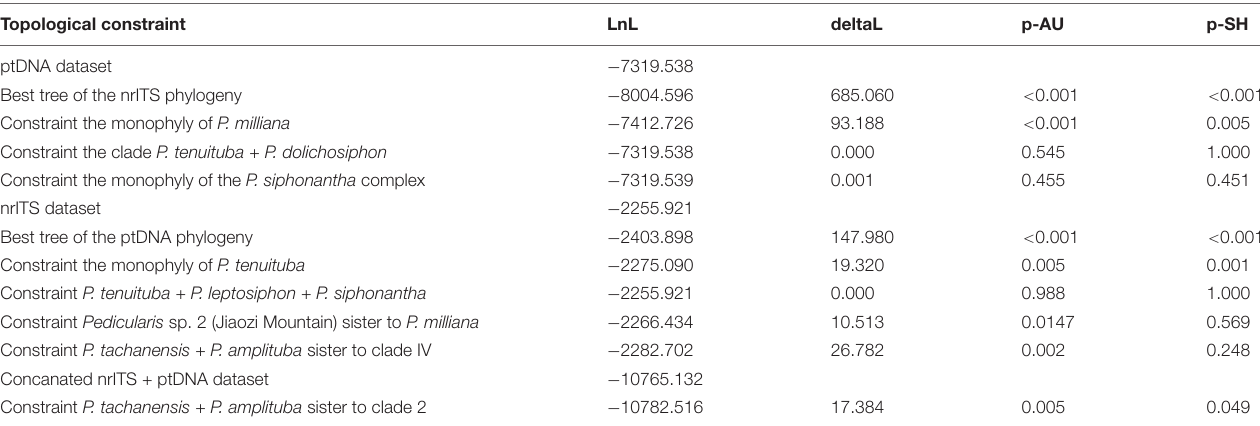
FIGURE 4 | Bayesian Inference (BI) tree comparisons of Pedicularis siphonantha complex inferred from nrITS (A) and the concatenated chloroplast (B) datasets. Phylogenetic incongruence is marked by shadow, Numbers associated with the branches are bootstrap value (BS) and BI posterior probabilities (PP), and thicker lines are indicated as BS ≥ 70 and PP ≥ 0.95. Node with BS < 50 was collapsed. TABLE 3 | Summary of the Shimodaira–Hasegawa (SH) and the Approximately Unbiased (AU)